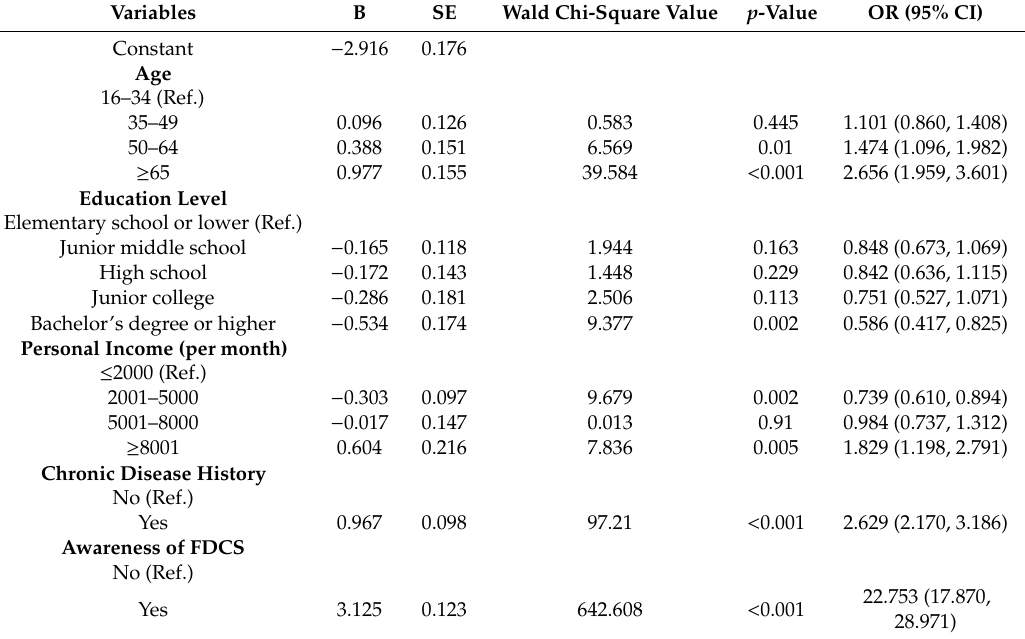
Table 3. Multivariate logistic regression analysis of the influencing factors associated with contracting with family